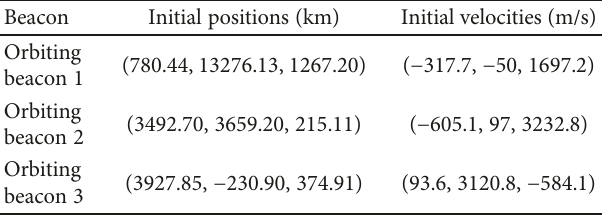
Table 3: Positions and velocities of